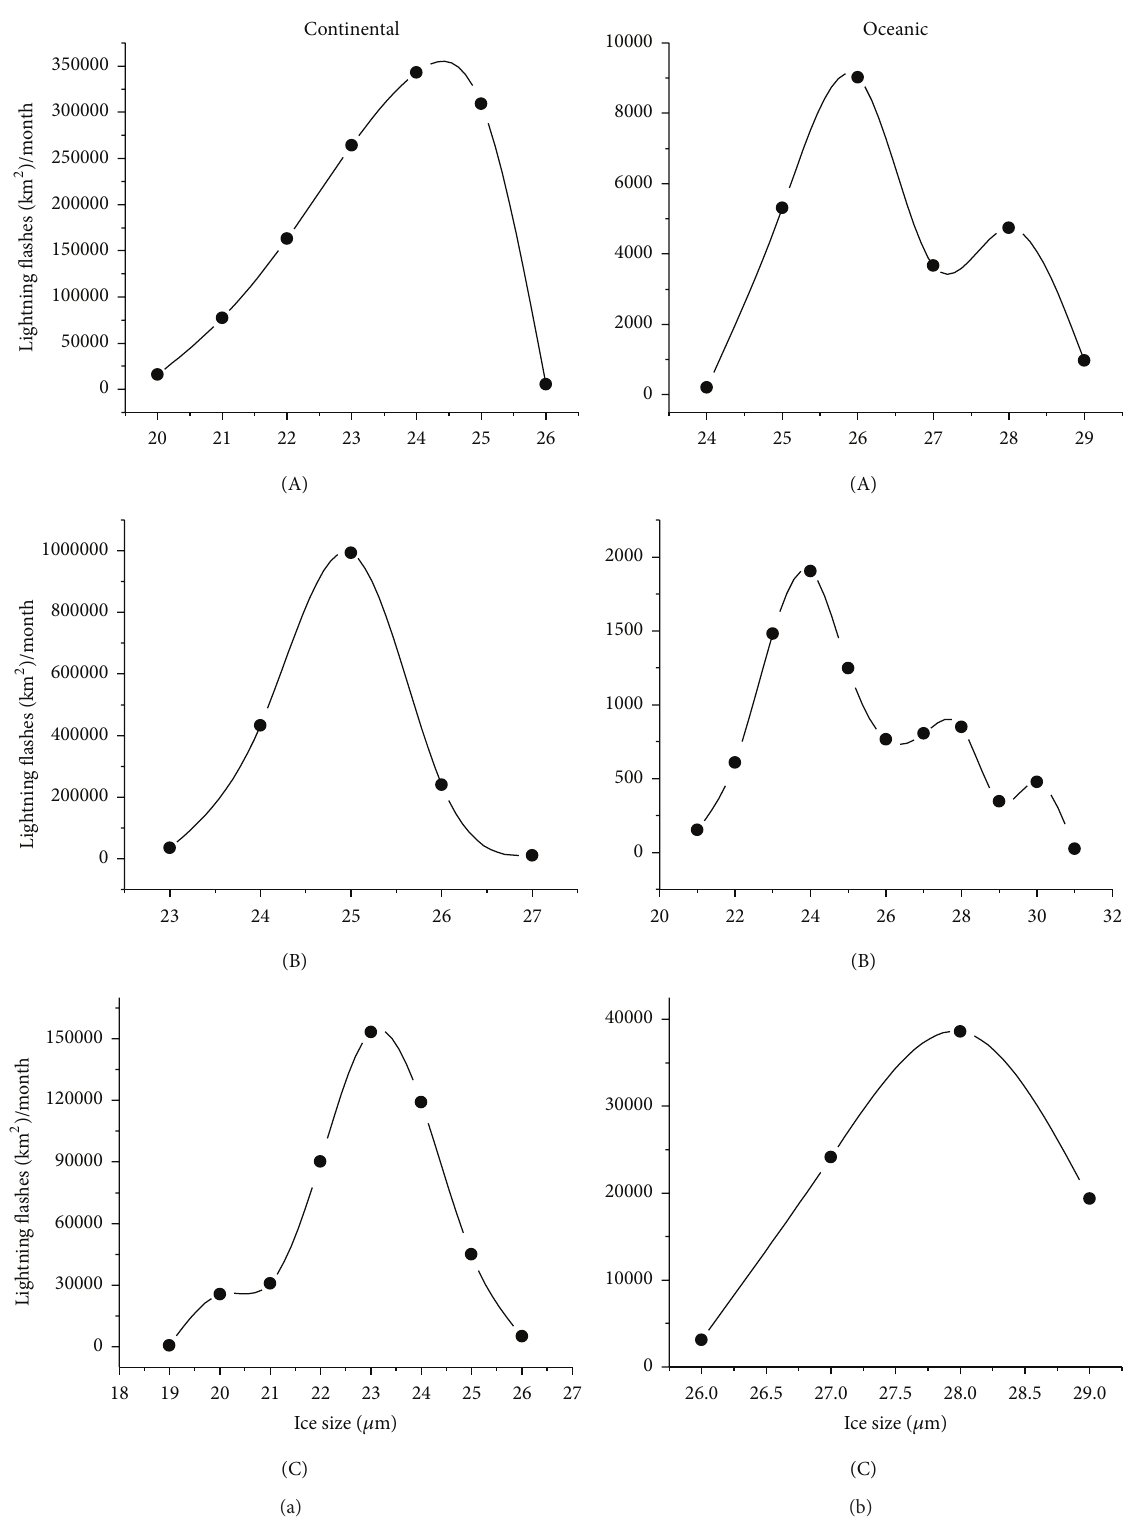
Figure 2: Relationship between mean cloud ice size and lightning over continental region (a) L1 (A), L2 (B), and L3 (C) and over oceanic region (b) O1 (A), O2 (B), and O3